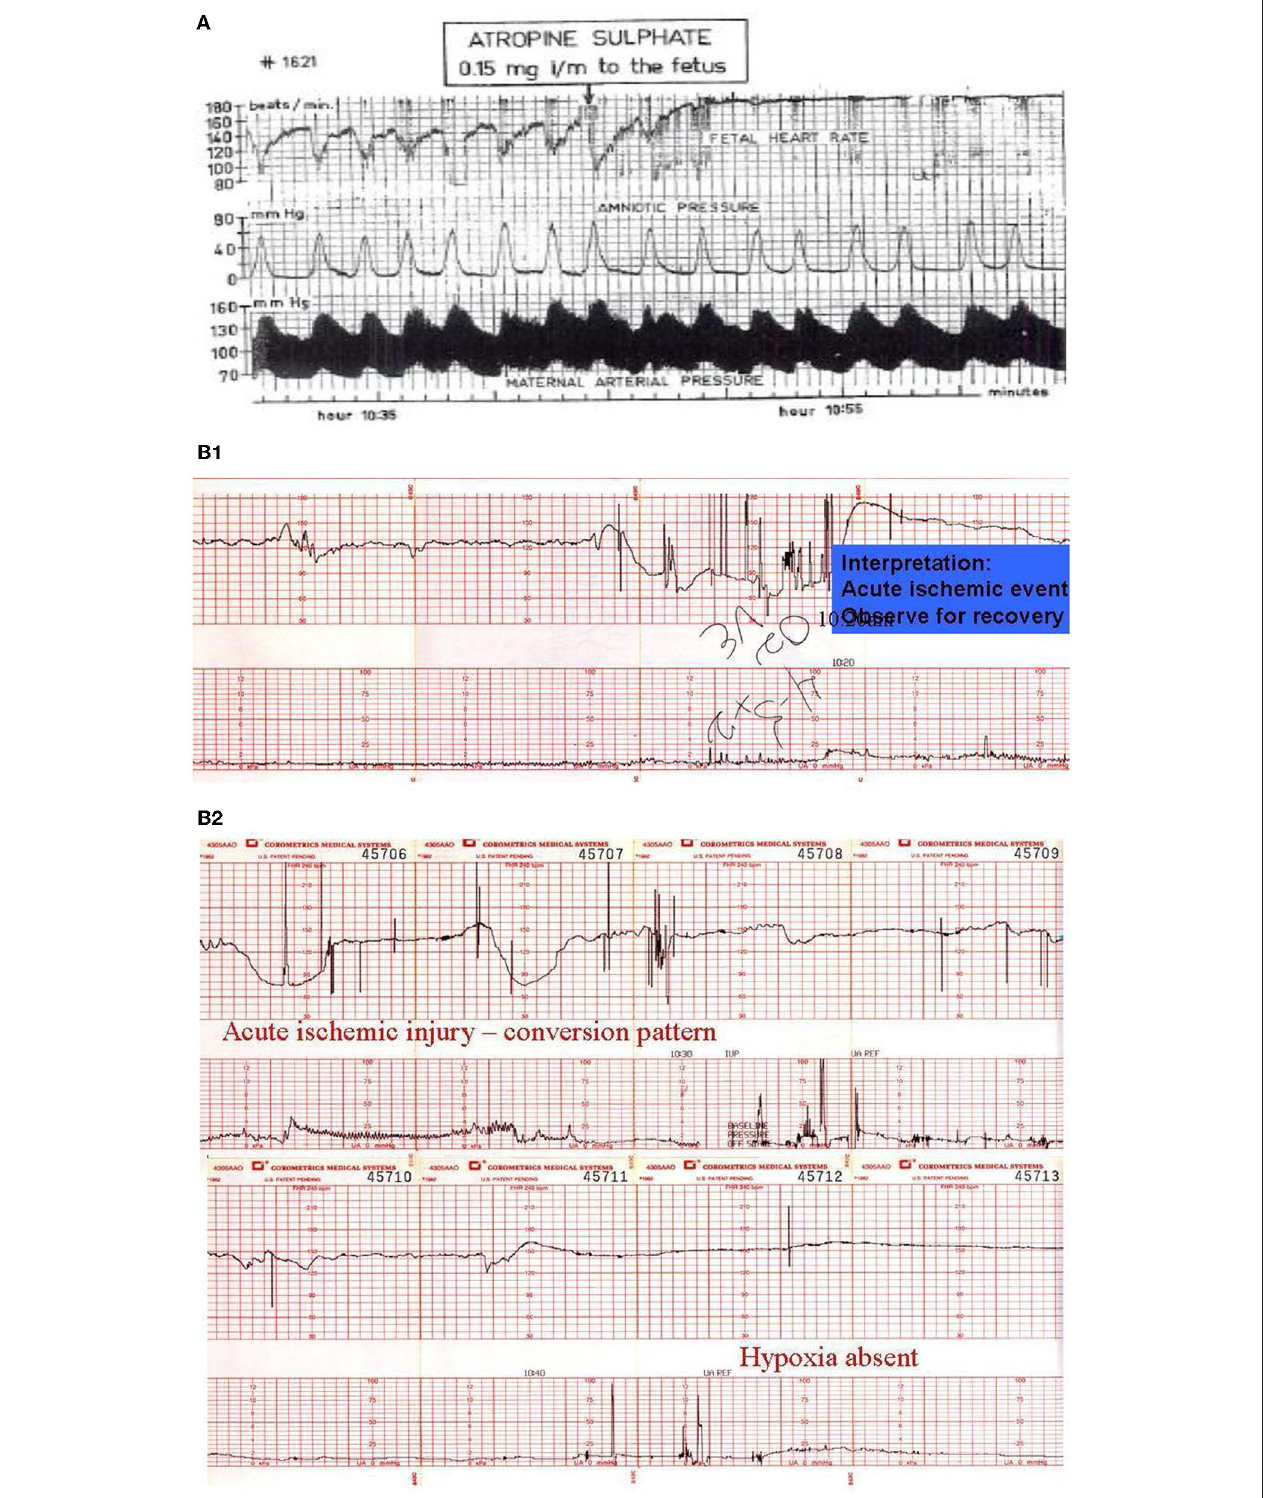
FIGURE 10 | (A) Illustrate the effects of atropine on the fetus during the 2nd stage of labor. Note the disappearance of the variable decelerations, the rise in baseline rate and the complete loss of baseline variability following the administration of atropine directly to the fetus (note scaling factor 30 bpm/cm vertical 1 cm/min horizontal). From: Schwarcz et al. (113). Scaling − 20 bpm/cm—vertical, 1 cm/min—horizontal—the panel is 60min wide. (B) Illustrates the appearance of a perinatal